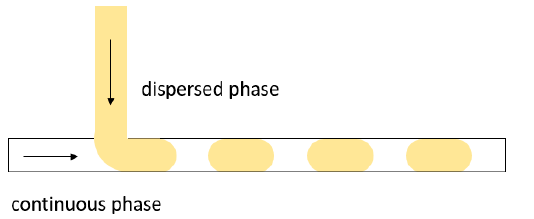
Figure 3. Droplet generation in a T-junction. Large droplets are formed in the channel, resulting in slug flow.